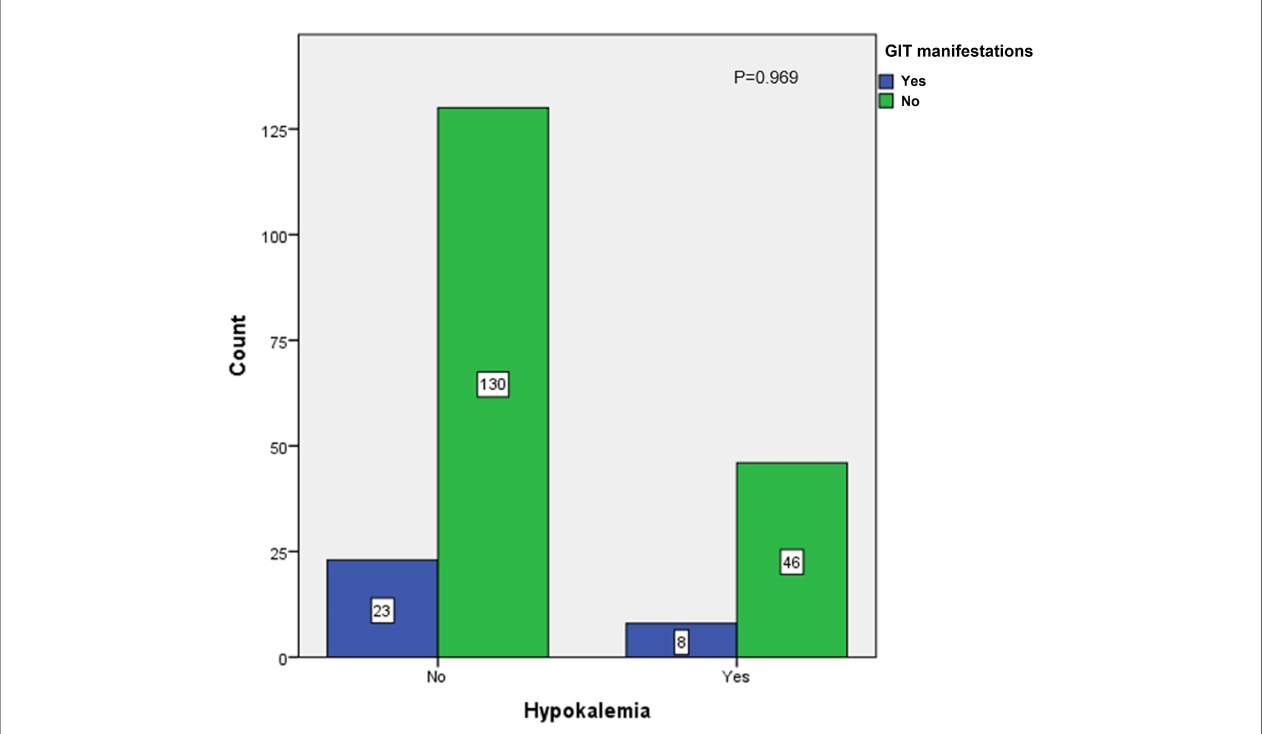
FIGURE 3 | Association between hypokalemia and development of gastrointestinal manifestations in the second COVID-19